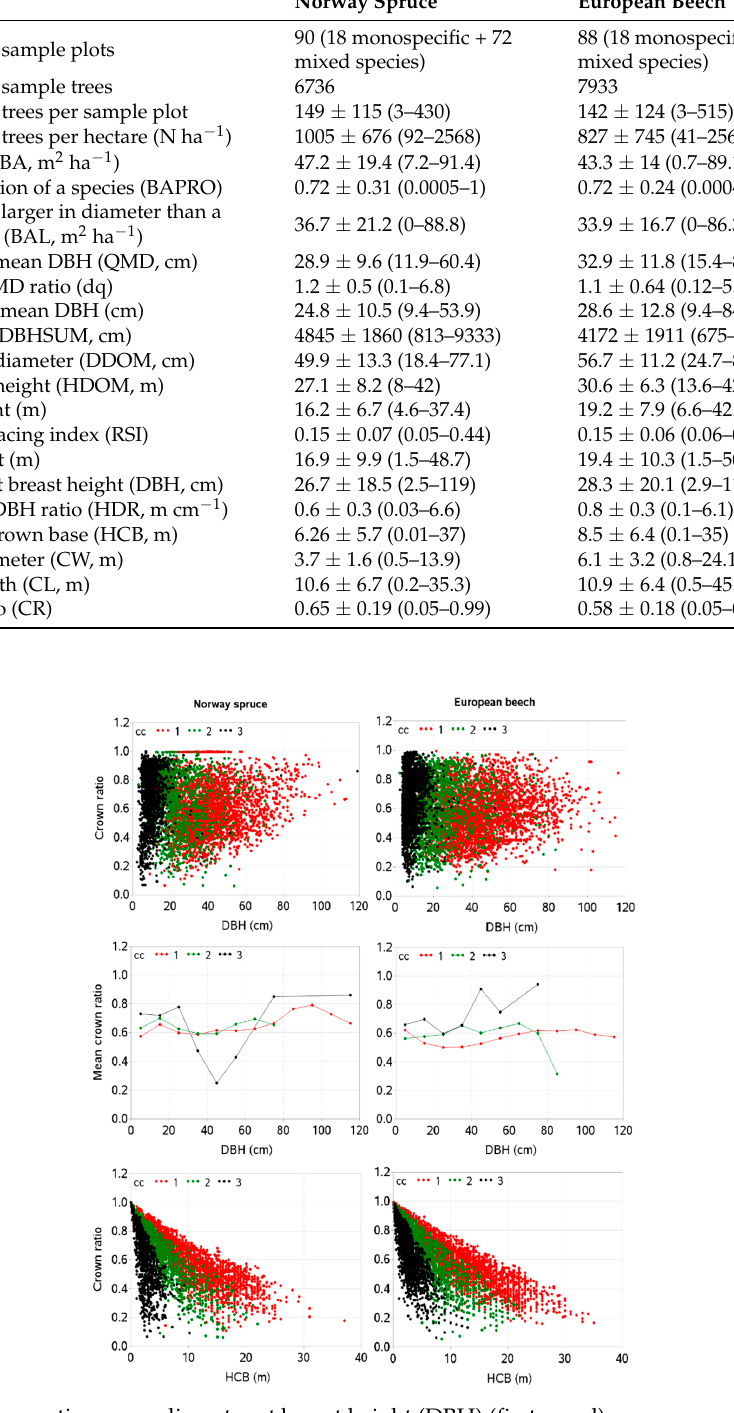
Figure 2. Crown ratio versus diameter at breast height (DBH) (first panel), mean crown ratio versus DBH (second panel), mean ratio was calculated by DBH class with 10 cm interval for each canopy class per sample plot; crown ration versus height to live crown base (HCB) for three different canopy height classes (third panel); CC = canopy height class 1: height greater than 66% of the tallest tree, 2: height between 33% and 66% of the tallest tree, and 3: height less than 33% of the tallest